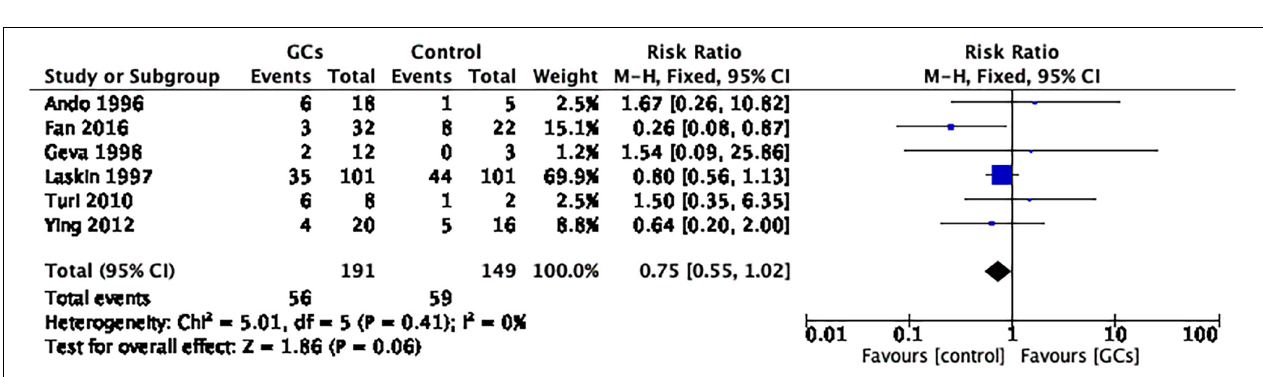
FIGURE 6 | Forrest plot for comparison: glucocorticoids versus no glucocorticoids/placebo, outcome: II. III Live birth rate per couple in subgroups by the time of treatment. Five studies initiated glucocorticoid treatment before confirmation of pregnancy, and one study initiated glucocorticoid treatment after confirmation of pregnancy. The former favors glucocorticoid use (RR 2.30, 95% CI 1.58–3.34, p < 0.0001, five cohort studies, 442 women, I 2 = 0%), while the latter does not (RR 1.16, 95% CI 0.93–1.45, p = 0.20, one cohort study, 202 women).